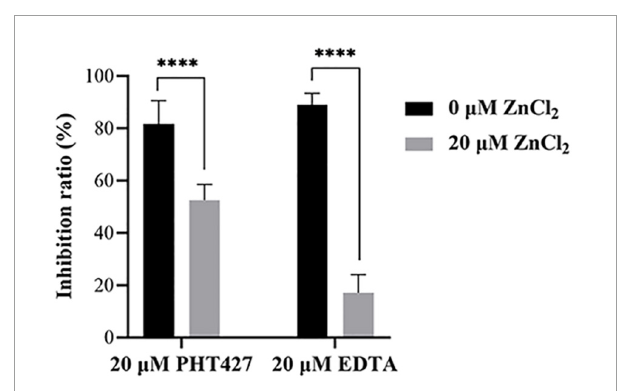
FIGURE5 Zinc supplementation assay. Inhibitory activity of NDM-1 enzyme with PHT427, EDTA, PHT427 + ZnCl 2 , and EDTA + ZnCl 2 , respectively. ∗∗∗∗ was indicated as P <